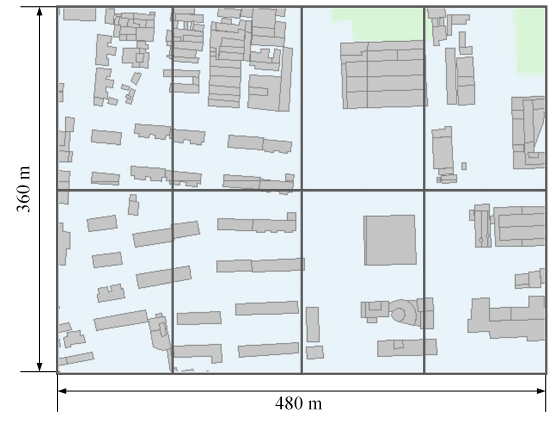
Figure 3. The gridding of the study area in Tsinghua